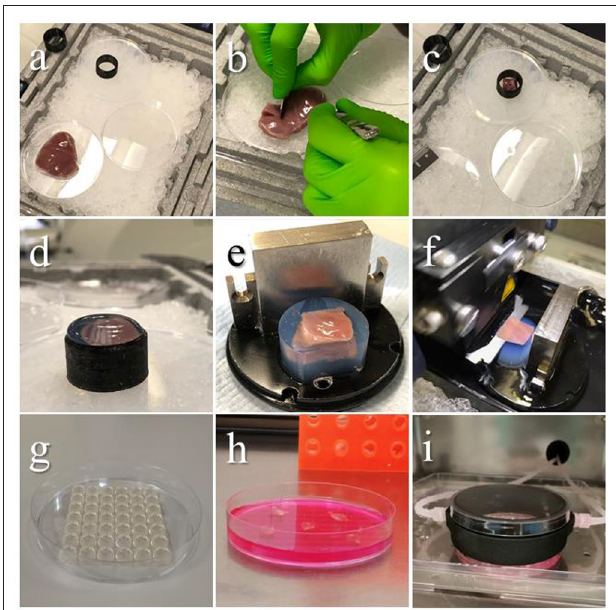
FIGURE 3 | Embedding procedure and slicing. Images showing the steps of tissue preparation for cutting epicardial slices. (a) The ventricles are isolated avoiding any direct handling of the epicardium and placed on ice throughout the procedure. (b) Tissue blocks are dissected by making an incision through the ventricular wall with a single edge steel blade and (c) placed on cold agarose inside a 3D printed plastic ring, the epicardium facing down. (d) The plastic ring is filled with low melting agarose. (e) Once solidified, the block is removed from the ring, squared and mounted on the holder using cyanoacrylate glue. (f) Epicardial slices are cut using a vibratome, with the blade speed at 0.03 mm/s. (g–i) Epicardial slices are pinned to pillared Petri dishes, and either cultured in static conditions changing medium every 24h, or connected to BioFlo120 r benchtop bioprocessor through a custom 3D-printed insert, enabling flow culture and control of the culture conditions. Source: Maselli et al. (